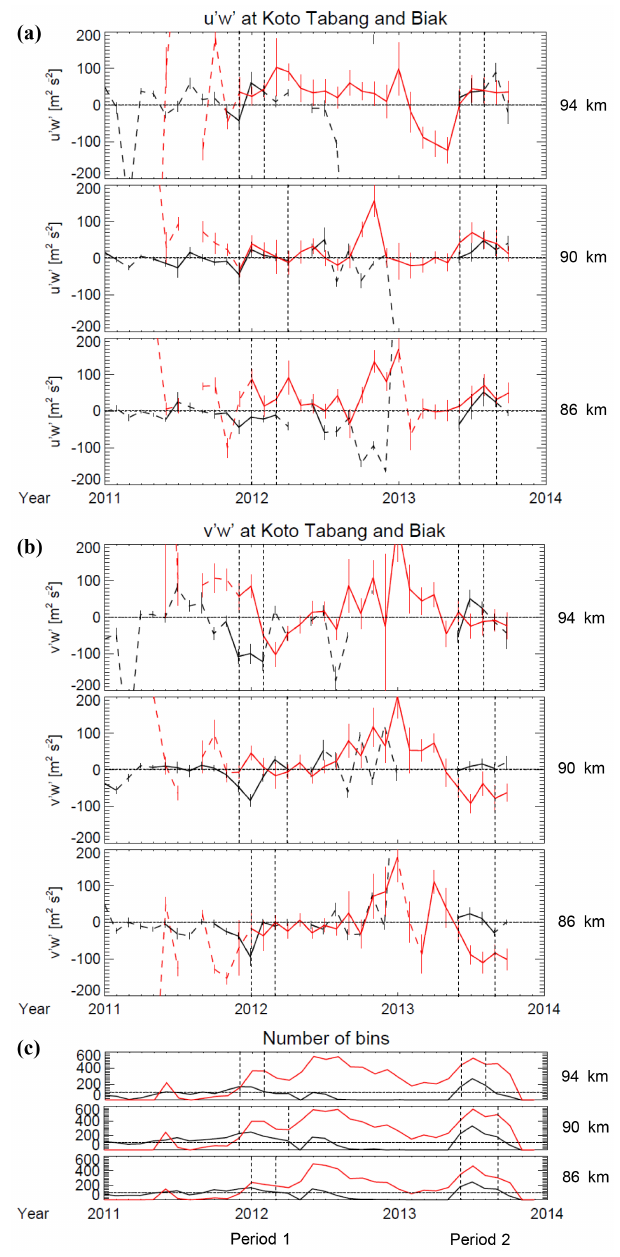
Figure 1. Monthly mean (a) u (cid:48) w (cid:48) and (b) v (cid:48) w (cid:48) at Koto Tabang (black line) and Biak (red line) at 86, 90, and 94km, and (c) the number of bins used to determine u (cid:48) w (cid:48) and v (cid:48) w (cid:48) at 86, 90, and 94km. Error bars of u (cid:48) w (cid:48) and v (cid:48) w (cid:48) indicate the 95% confidence interval. The solid line for u (cid:48) w (cid:48) and v (cid:48) w (cid:48) corresponds to the obser- vation period when the number of bins was larger than 100, while the dashed line for u (cid:48) w (cid:48) and v (cid:48) w (cid:48) indicate the period with the fewer than 100 bins. The vertical dotted lines show the observation period when the number of bins was greater than 100 for both sites at each